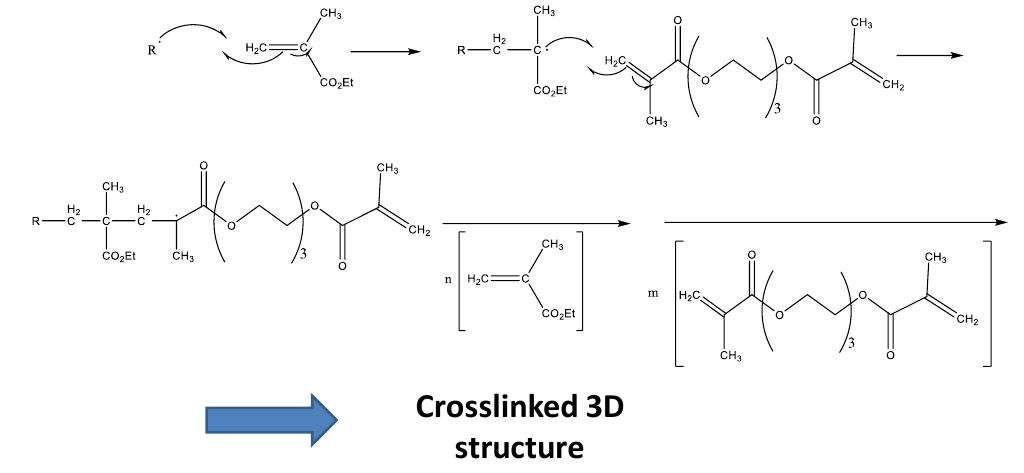
Figure 3. Scheme of the random polymerization process.